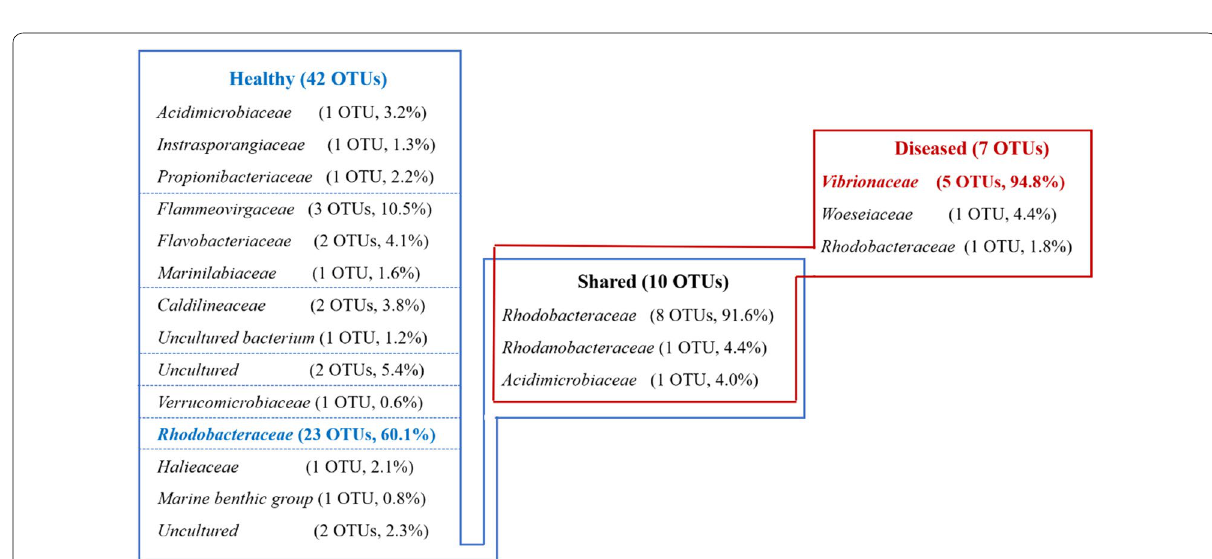
Fig. 4 Taxonomy of core OTUs assigned to health state clusters at the family level and their abundances and average relative abundances in core microbiota of each